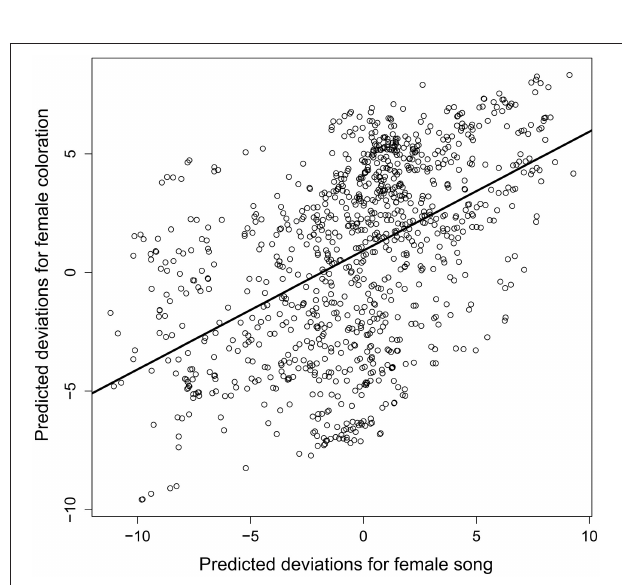
FIGURE 4 | Plot of best linear unbiased predictions of the phylogenetic association between female song and female plumage color elaboration. Points indicate the predicted phylogenetic deviations of each species (i.e., the 1023 species tips within the pruned phylogenetic tree) for the two female display traits, and solid line denotes the posterior mean phylogenetic correlation between female song with female